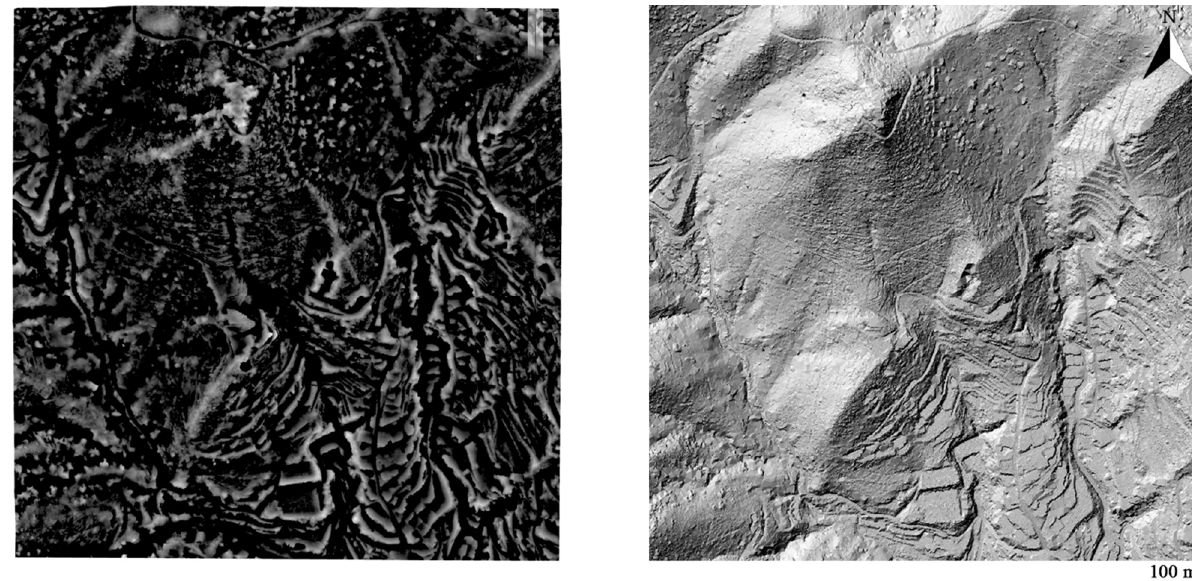
Figure 6. MSRM ( left ) and hillshade ( right ) of the Burriac site.